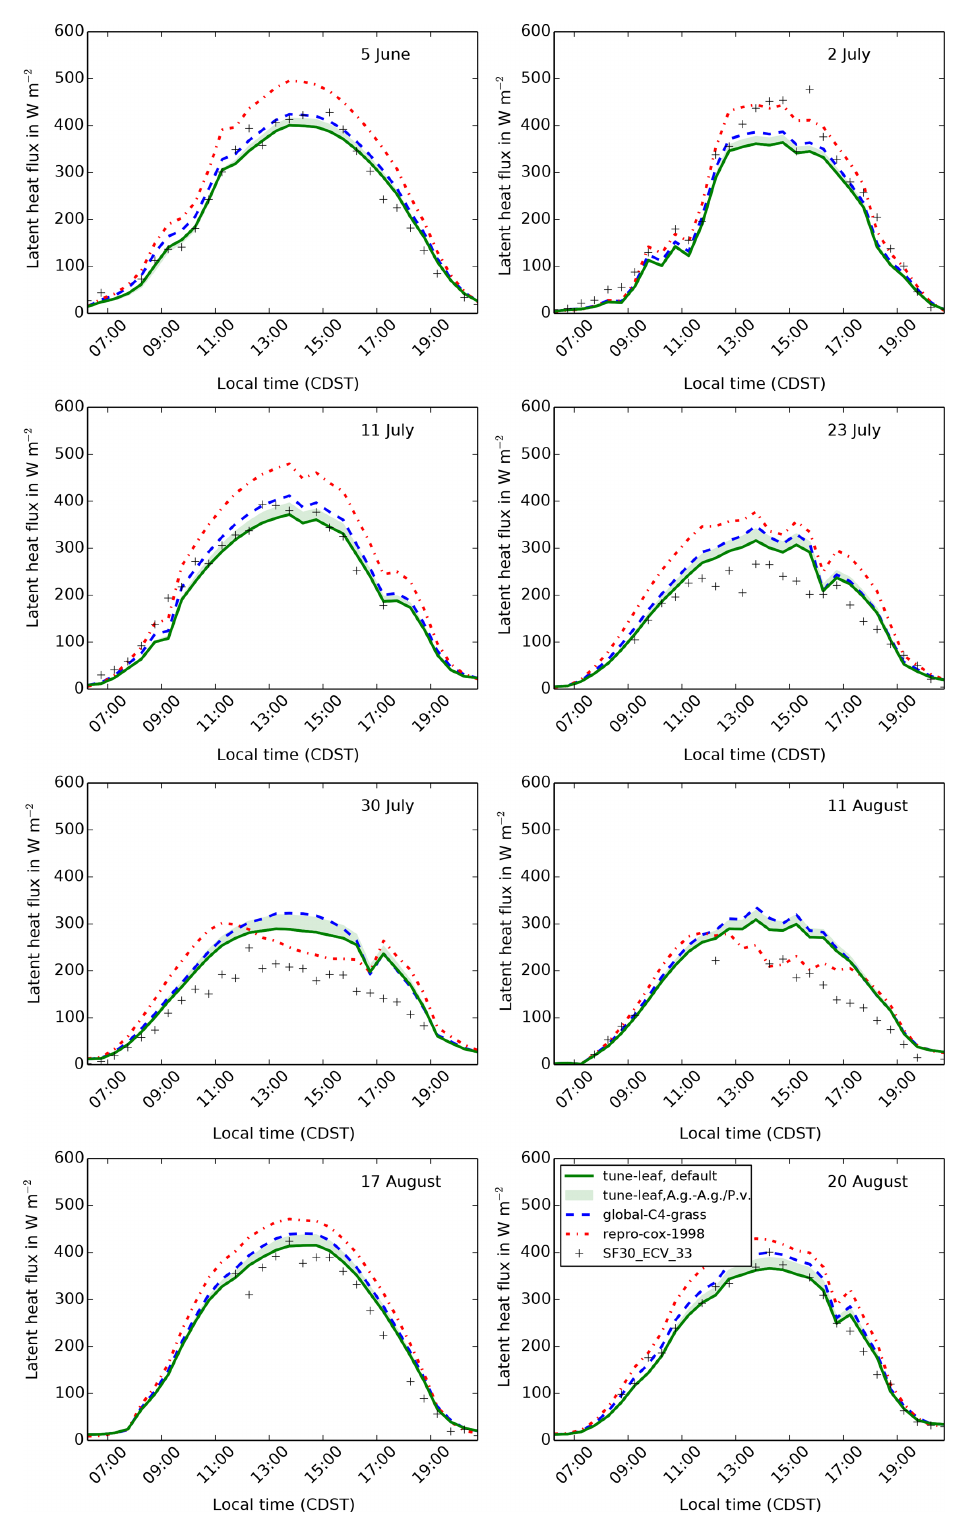
Figure 11. The diurnal cycle of latent heat flux at site 4439 in the FIFE area for 8 days in 1987: 5 June (early growth), 2 and 11 July (peak growth), 23 July, 30 July and 11 August (dry period), and 17 and 20 August (early senescence). Green band shows uncertainty from fitting plant parameters to A. gerardii compared to fitting to both A. gerardii and P. virgatum (upper limit corresponds to the combined A. g., P. v. fit, lower limit to the A. g. fit (i.e. the default tune-leaf